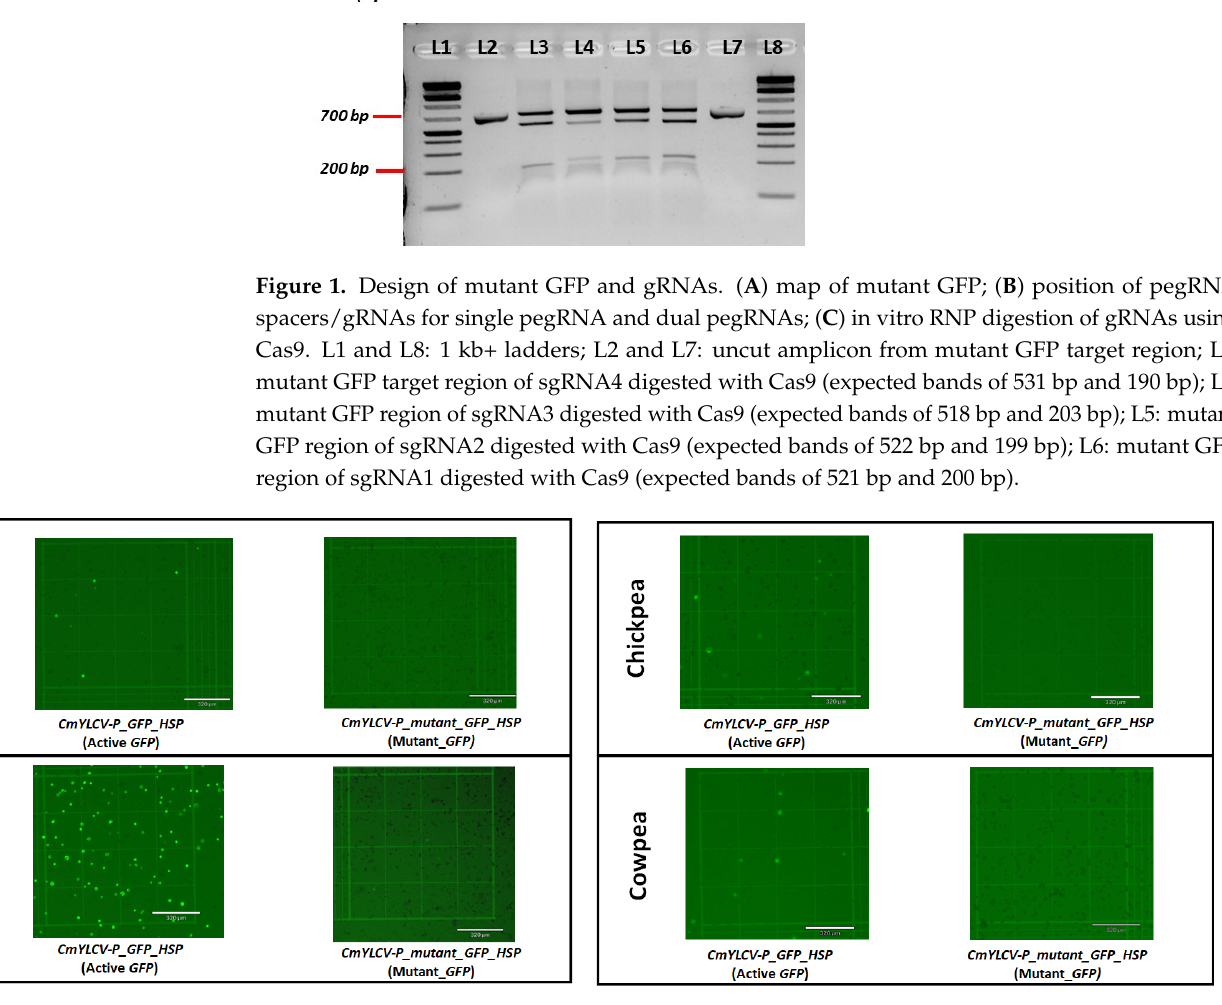
Figure 1. Design of mutant GFP and gRNAs. ( A ) map of mutant GFP; ( B ) position of pegRNA spacers/gRNAs for single pegRNA and dual pegRNAs; ( C ) in vitro RNP digestion of gRNAs using Cas9. L1 and L8: 1 kb+ ladders; L2 and L7: uncut amplicon from mutant GFP target region; L3: mutant GFP target region of sgRNA4 digested with Cas9 (expected bands of 531 bp and 190 bp); L4: mutant GFP region of sgRNA3 digested with Cas9 (expected bands of 518 bp and 203 bp); L5: mutant GFP region of sgRNA2 digested with Cas9 (expected bands of 522 bp and 199 bp); L6: mutant GFP region of sgRNA1 digested with Cas9 (expected bands of 521 bp and 200 bp).